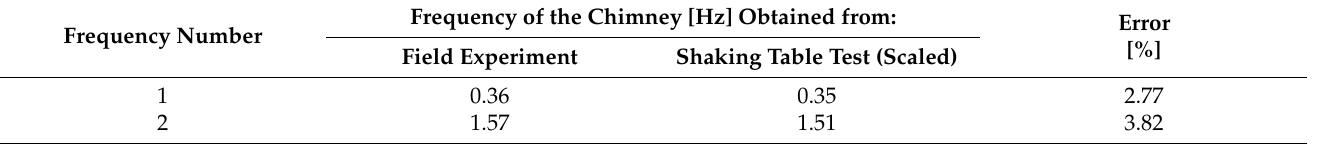
Table 6. The natural frequencies of the chimney obtained from the field experiment and the shaking table test. Frequency of the Chimney [Hz] Obtained